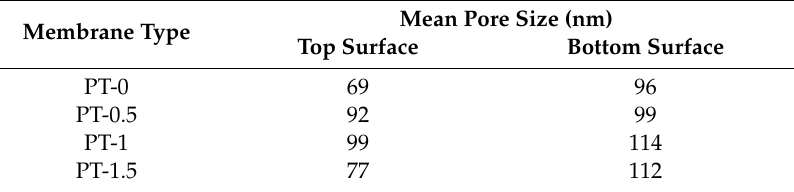
Table 3. Effect of TiO 2 concentration on the mean pore size of the top and bottom surfaces of the prepared membranes.